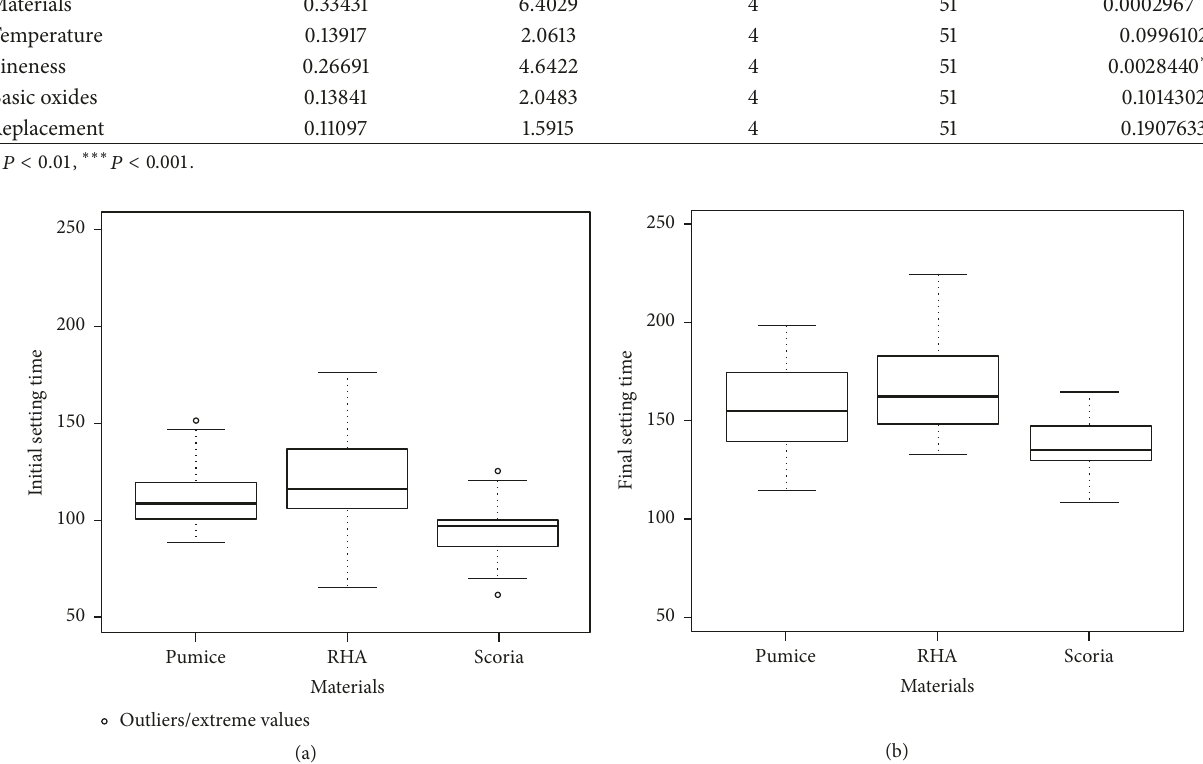
Figure 4: Influence of materials on setting times: (a) initial setting time and (b) final setting time.